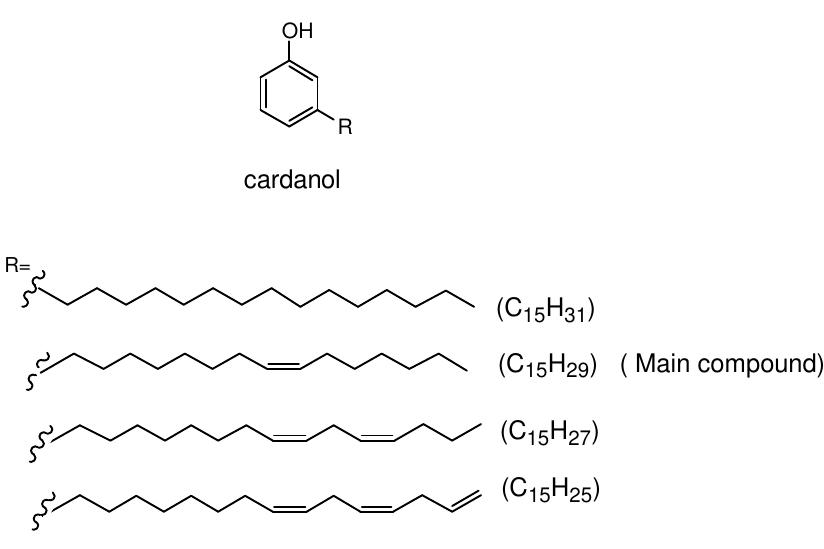
Figure 1. Main components of the cardanol